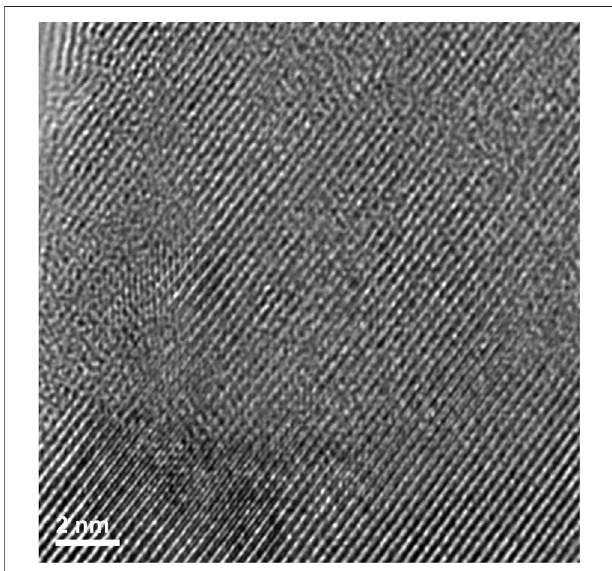
FIGURE 14 | High magni fi cation image showing how the disorder exists for irradiated Nd 2 Zr 2 O 7 within the region where lattice fringes are visible.